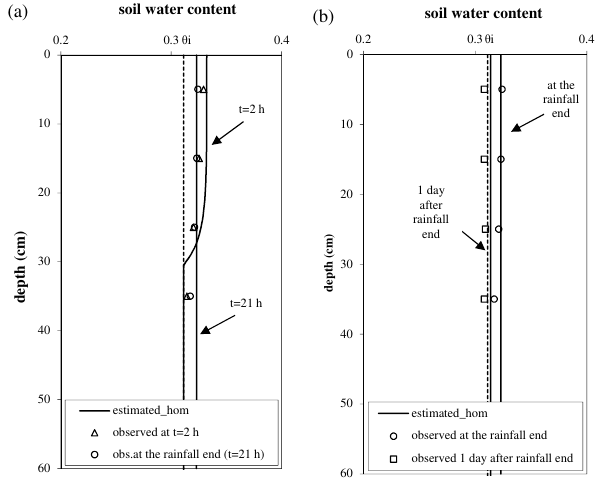
Fig. 9. Water content profiles simulated by the adopted model for Figure 9. Water content profiles simulated by the adopted model for homogeneous soil and specific homogeneous soil and specific values observed at different depths values observed at different depths during (a) the infiltration stage, (b) the redistribution stage. during (a) the infiltration stage, (b) the redistribution stage. Event 7 Event 7 of Fig. 2 (see also Table 2). Saturated hydraulic conductivity 2 mmh -1 . of Fig. 2 (see also Table 2). Saturated hydraulic conductivity 2mmh − 1 .